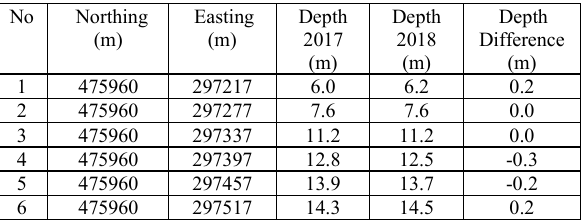
Table 3. Depth comparison between 2017 and 2018 relative to